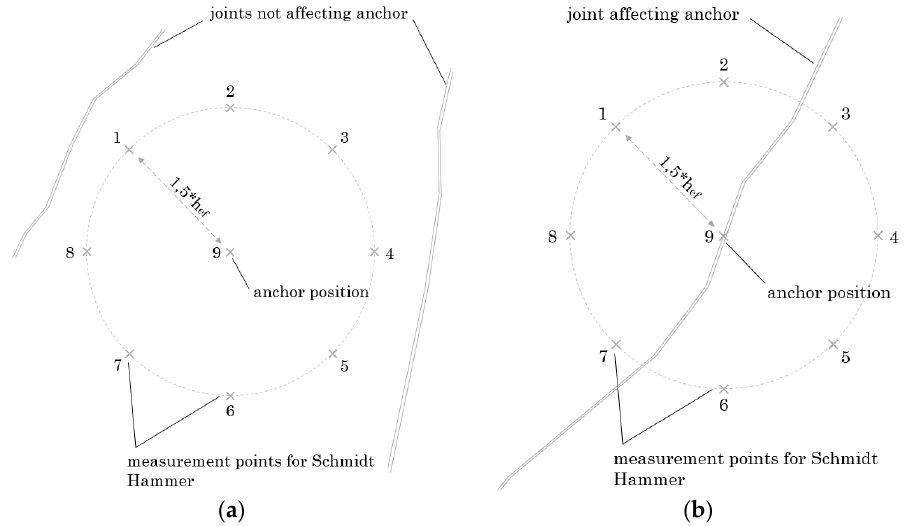
Figure 2. Anchor positions one to nine in ( a ) undisturbed area (not affected by visual detectable joints) and ( b ) disturbed area (affected by joints).